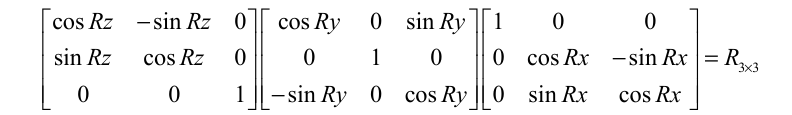
system. The error is defined by the Gauss–Newton algorithm, and the translation vector t and rotation vector R are calculated. Finally, the position and orientation information of the CP can be